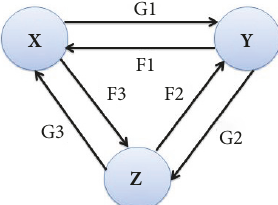
Figure 1: The framework of MMGANs model. In this model, there are six generators (G1, F1, G2, F2, G3, and F3) and the letters ‘X’, ‘Y’, and ‘Z’ represent different domains.